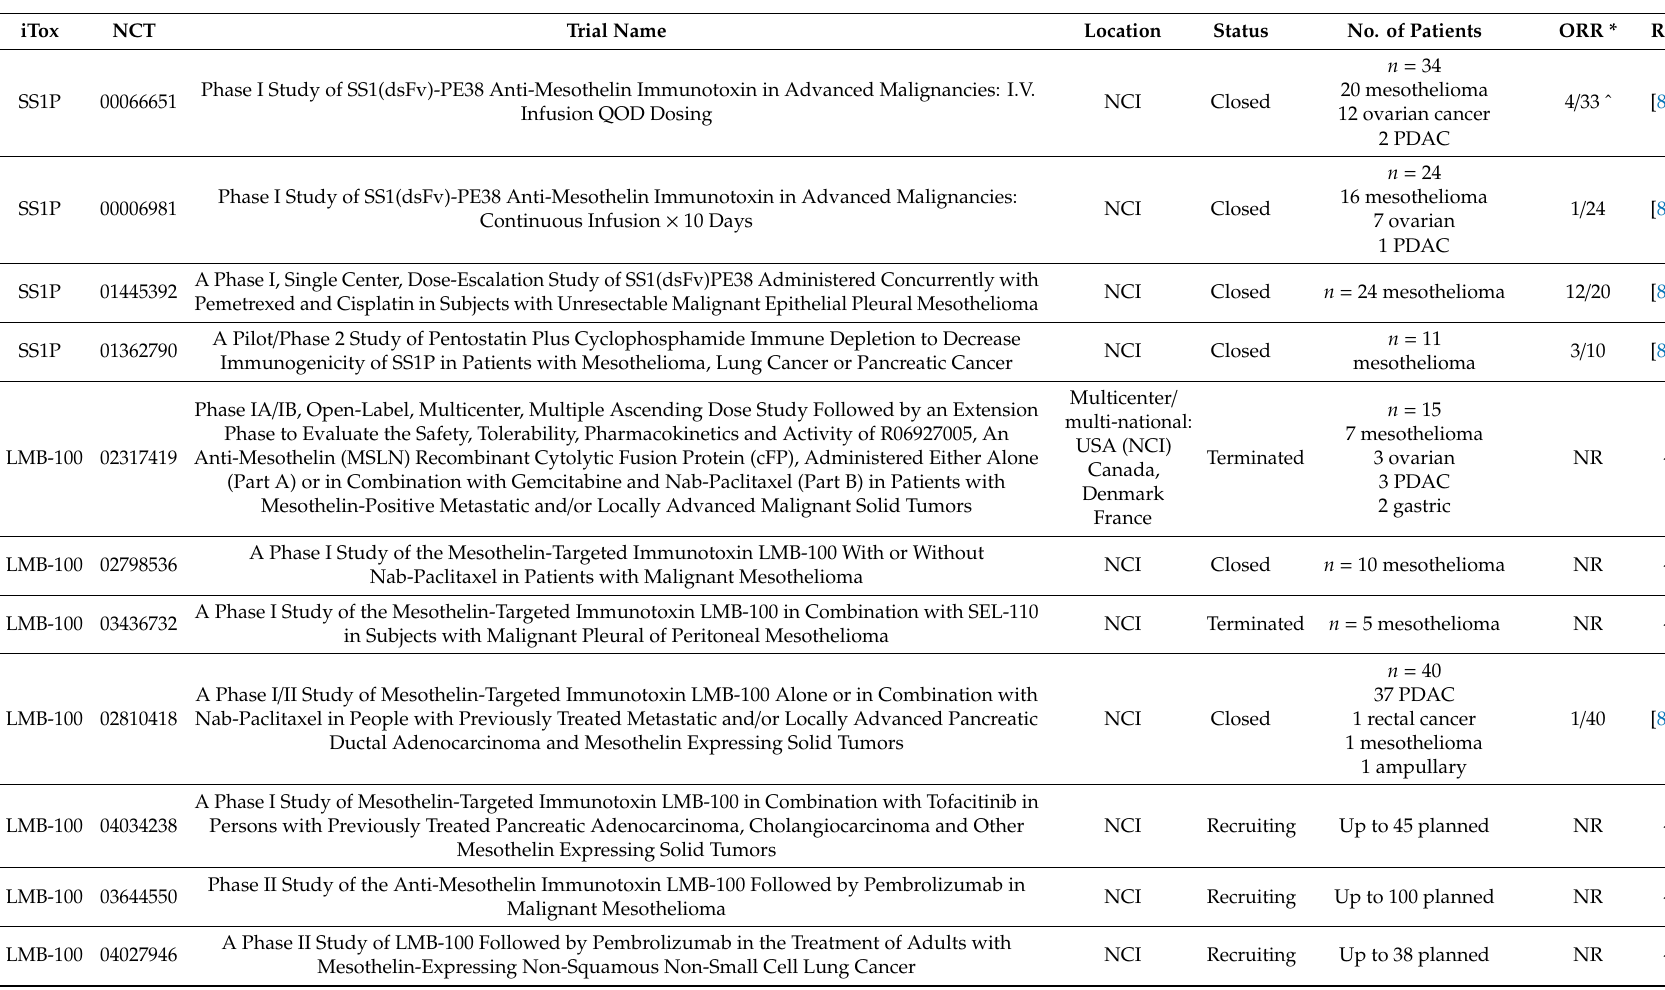
Table 1. Summary of clinical trials of MSLN-targeted immunotoxins. Trials without references do not have published results at the time of submission of this